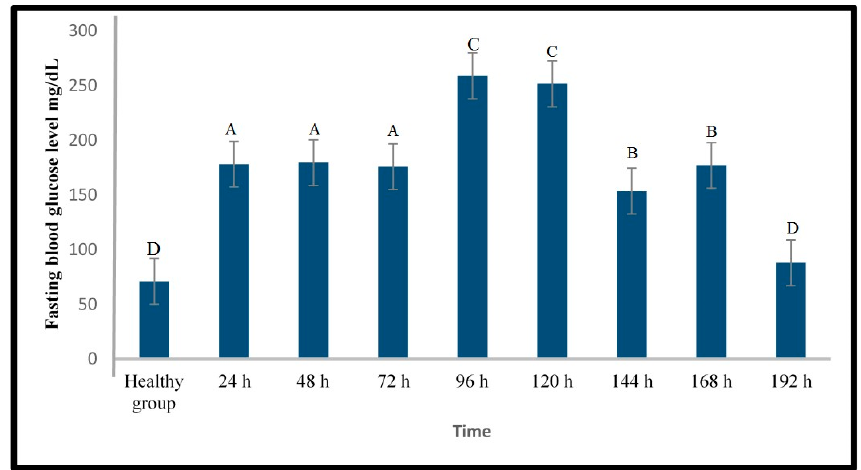
Figure 5. Fasting blood glucose level of zebrafish analyzed after injection of 300 mg alloxan/kg for 8 days. Different capital letter indicates significant difference ( p < 0.05) among the values, n = 10.